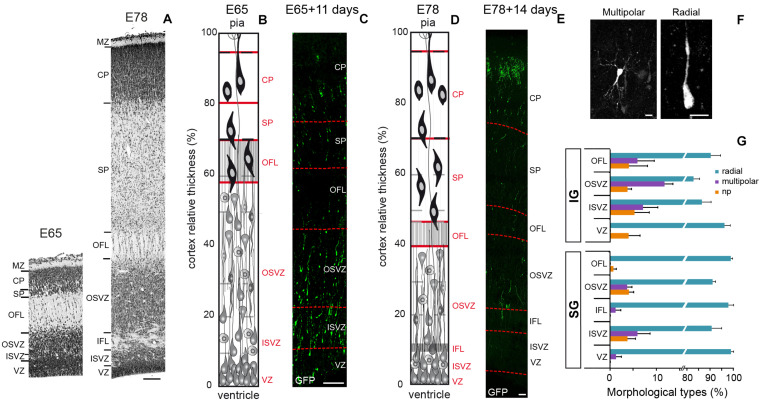
(A) Transects of Area 17 at E65 (left) and E78 (Right). (B) Area 17 cellular organization at E65. (C) Transect of a A17 parasagittal organotypic slice 11 days after EGFP retroviral infection of cycling precursors at E65. A fraction of EGFP+ neurons have migrated and reached the CP. (D) Area 17 cellular organization at E78. (E) Transect of a A17 parasagittal organotypic slice 14 days after retroviral infection at E78. EGFP+ neurons have reached the CP. (F) Microphotographs of EGFP+ neurons at the OFL/SP border showing multipolar (left panel) and radial morphology (right panel). (G) Frequency of the three morphological classes of EGFP+ early postmitotic migrating neurons in the occipital cortex subsequently to retroviral infection at E65 and E78, respectively: no process (np), radial (1–2 processes), and multipolar (≥3 processes). VZ, ventricular zone; ISVZ, inner subventricular zone; IFL, inner fiber layer; OSVZ, outer subventricular zone; OFL, outer fiber layer; SP, subplate; CP, cortical plate; MZ, marginal zone. Scale bars: A,C,E: 100 μm; F: 10 μm.